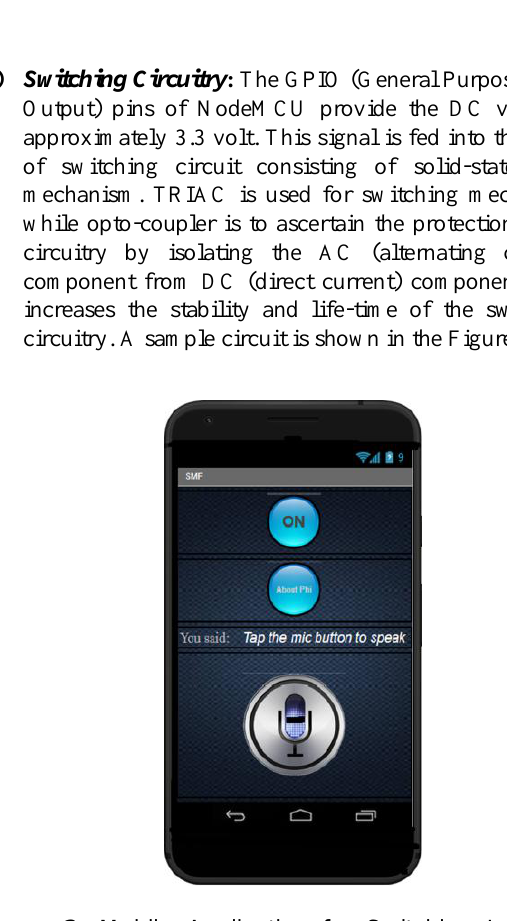
Figure 2. Mobile Application for Switching Interface